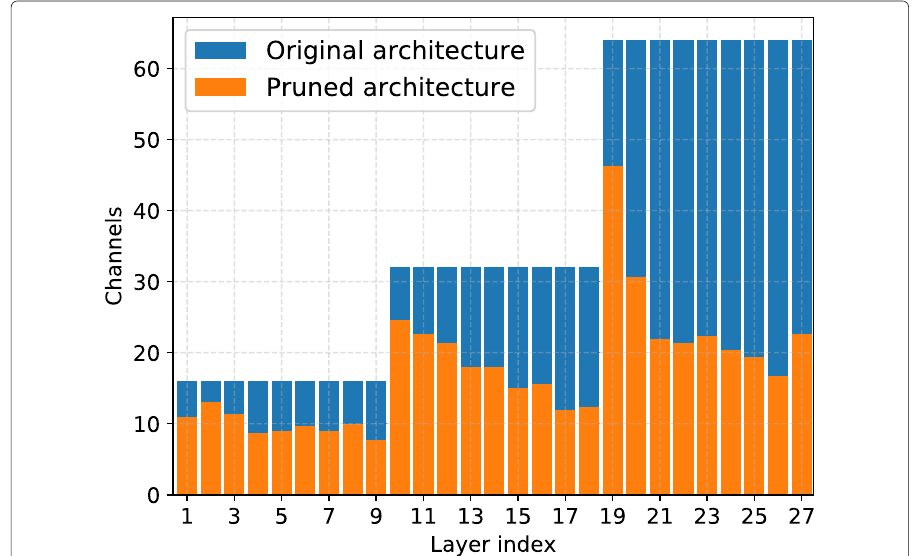
Fig. 10 Channel distribution of the pruned model for ResNet on CIFAR-10. We only present the pruned layers, namely the first layer within each residual block